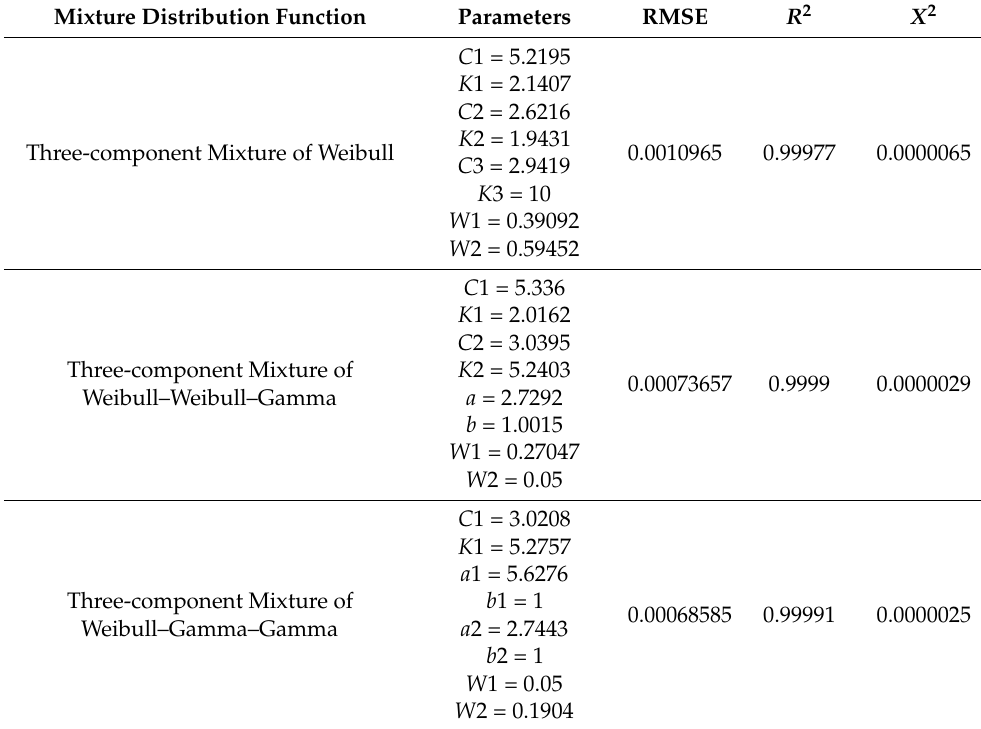
Table 3. Probability distribution parameters for the three-component mixtures of PDFs in wind speed